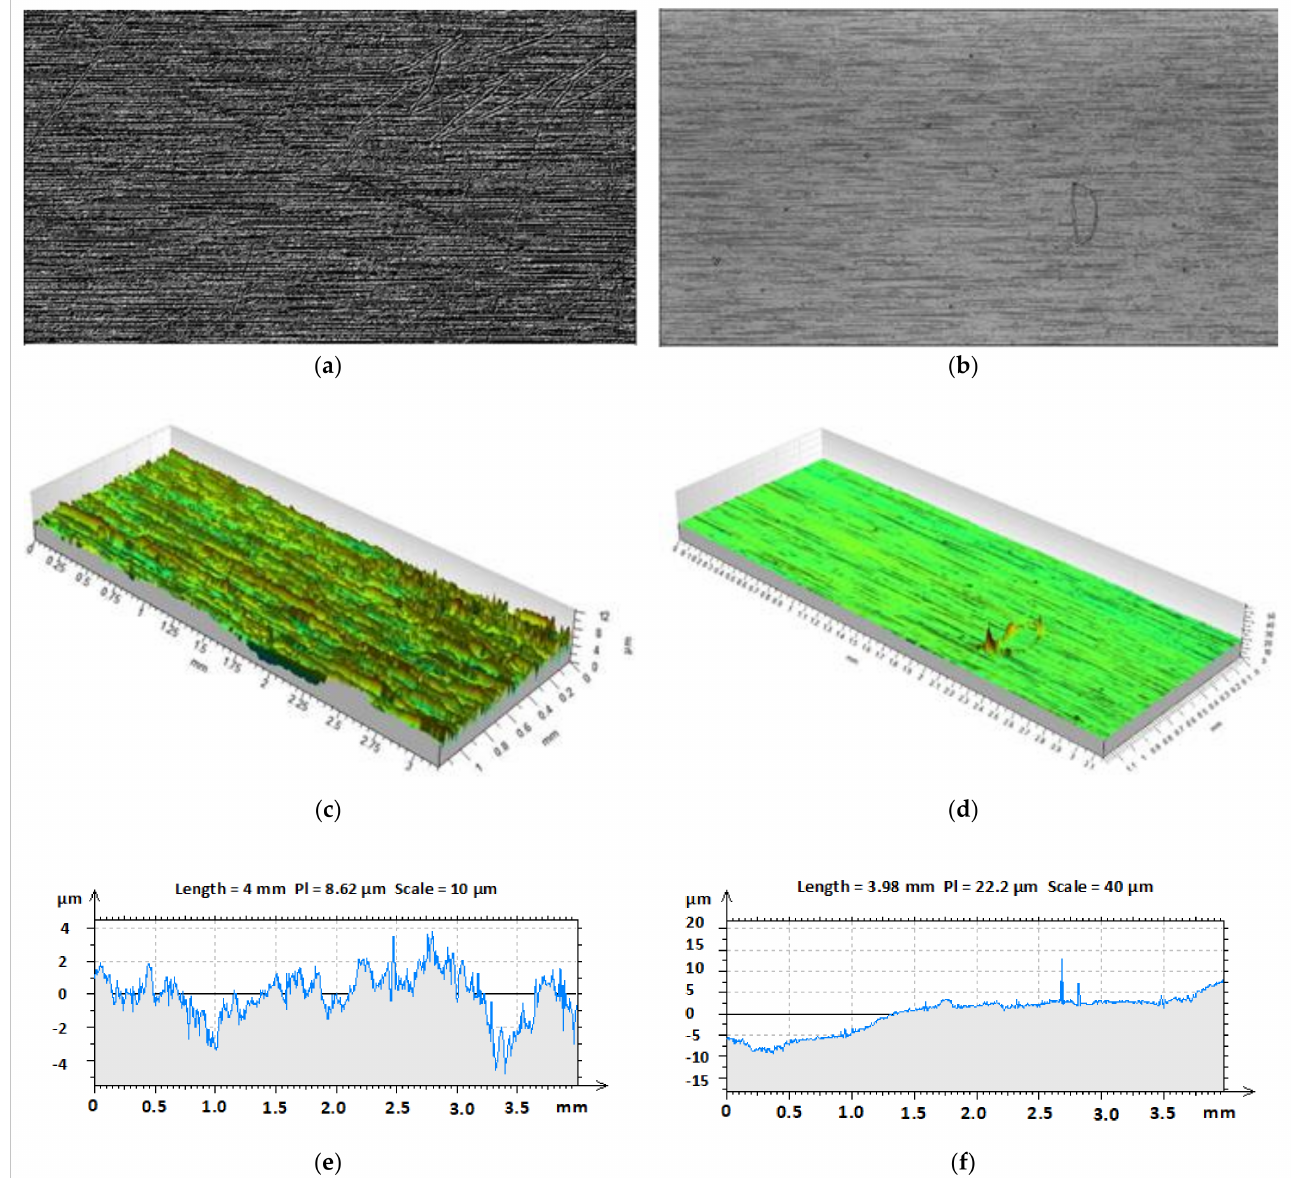
Figure 10. The surface quality—injection pressure 800 bar, flow length 0 mm: ( a ) mould; ( b ) product; ( c ) mould; ( d ) product; ( e ) profile of the mould; ( f ) profile of the